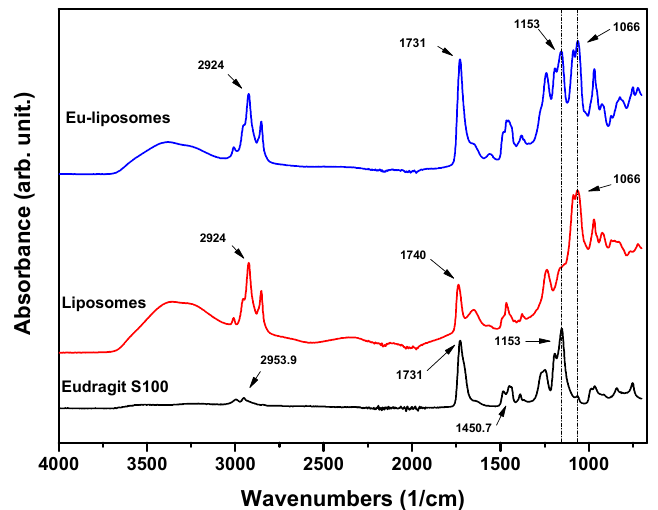
Figure 2. FTIR spectra of Eudragit S100 polymer (black line), liposomes (red line) and Eudragit coated liposomes (blue line).